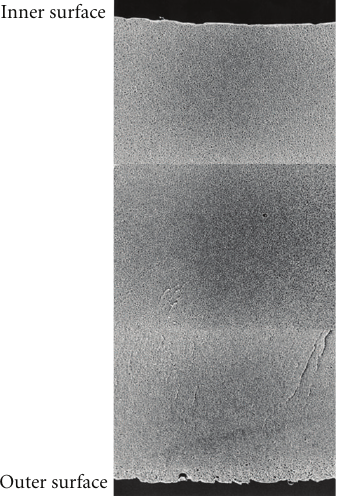
Figure 6: The scanning electron microscopy findings of cross- section structure of PMMA. PMMA has a symmetric structure having nearly homogenous microscopic pores from inner surface to outer surface of hollow fiber.